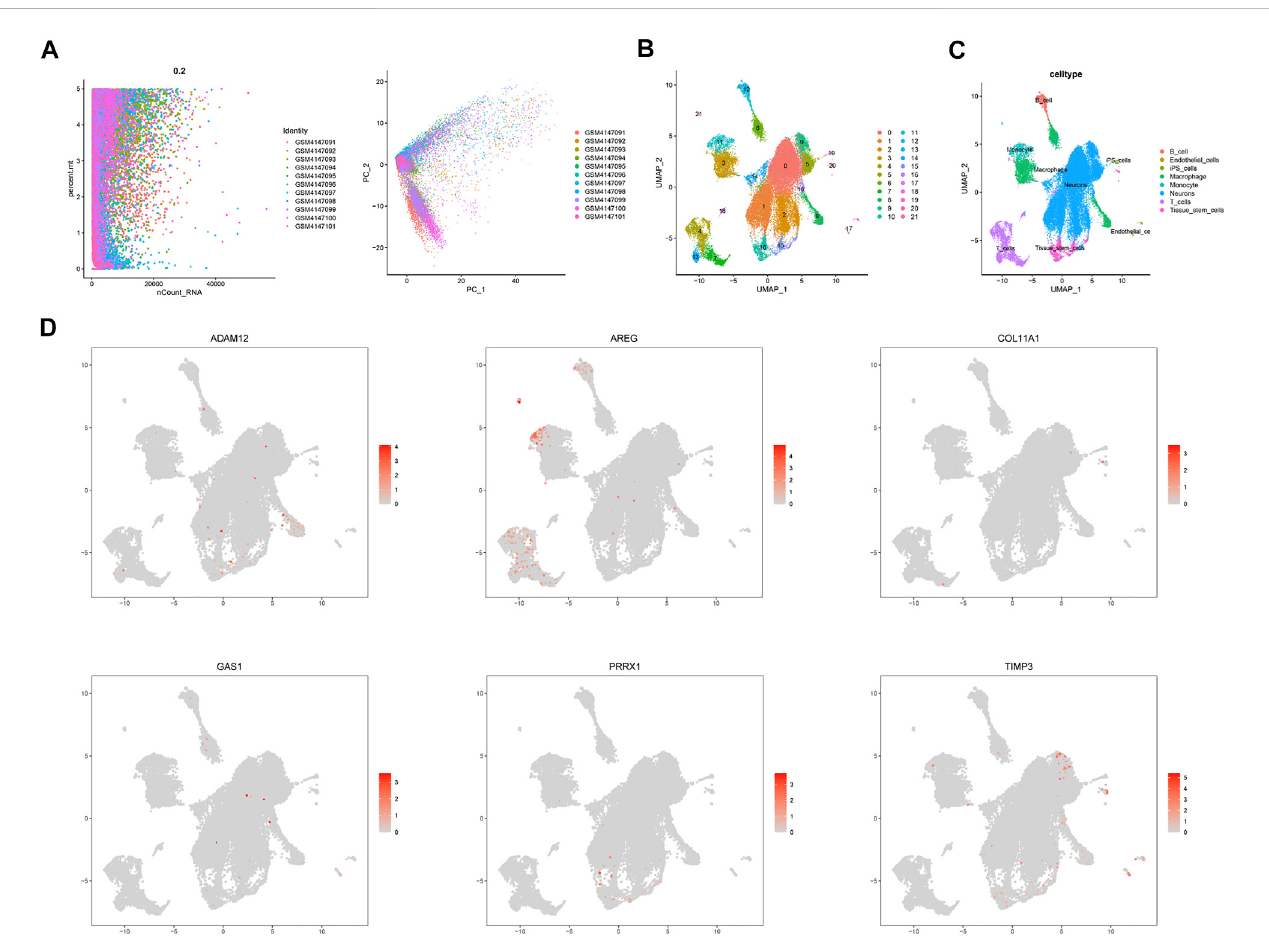
FIGURE 9 Single cell sequencing analysis. (A) Data integration of 11 samples. (B) Dimensionality reduction and cluster analysis. (C) The cells were classi fi ed into approximately 8 cell types, including B cells, endothelial cells, iPS cells, macrophage cells, monocyte cells, neurons, T cells and stem cells. (D) Cell location of each model